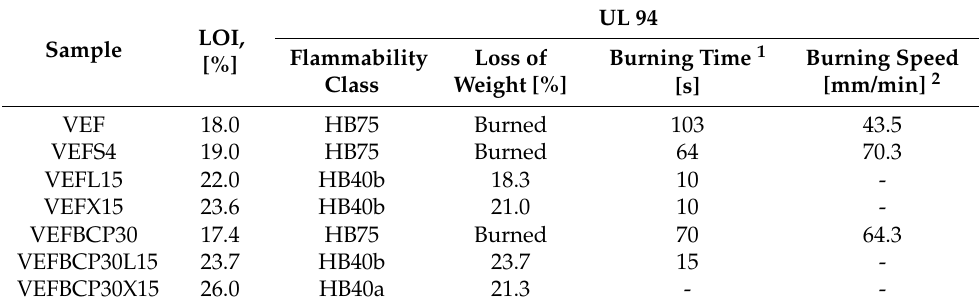
Table 8. Limiting oxygen index (LOI) analysis and UL94 test